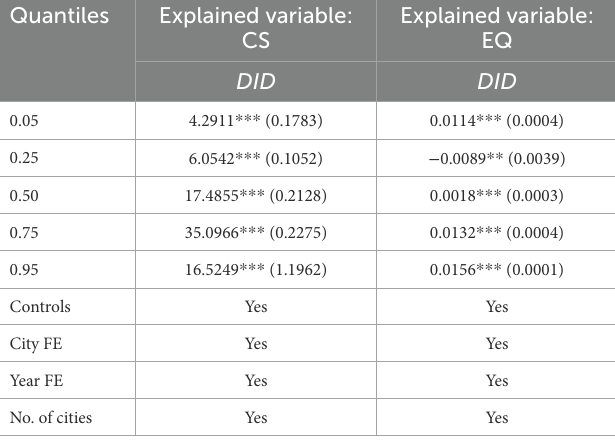
TABLE 7 Heterogeneity analysis: differences in distribution based on quantile